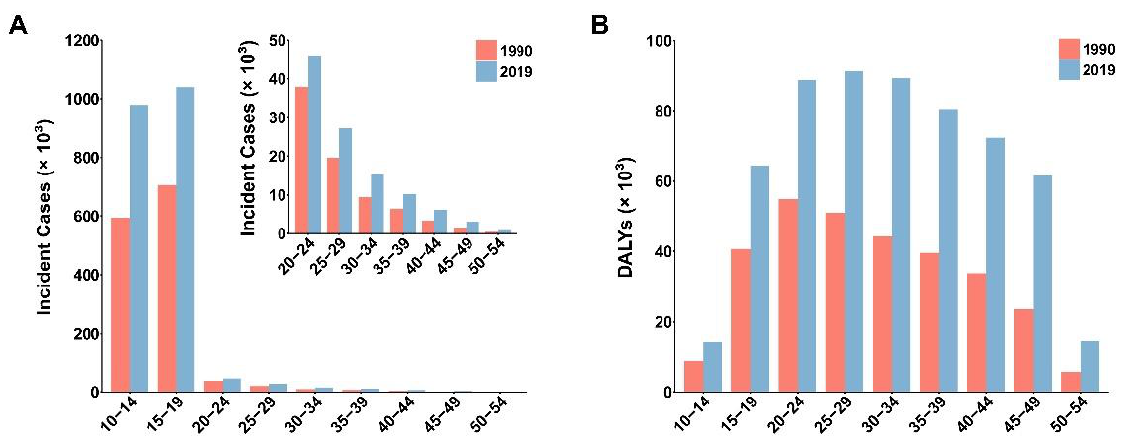
Figure 1. The incident cases ( A ) and DALYs ( B ) of PCOS at different age groups in 1990 and 2019. DALYs, disability-adjusted life years; PCOS, polycystic ovary syndrome.